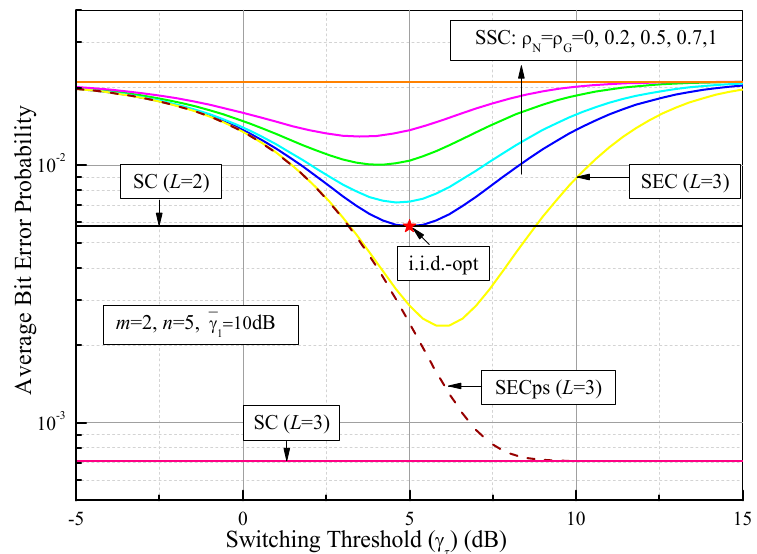
Figure 8. ABEP values of DPSK for the switched diversity systems as a function of the switching threshold ( γ τ ) over Fisher–Snedecor F fading channels with m = 2, n = 5, and γ 1 = 10